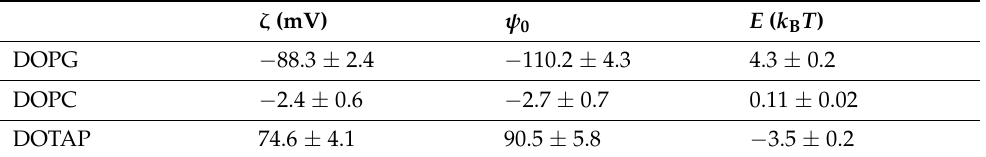
Table 1. Measured zeta potential, ζ , of lipid vesicles of the indicated composition between 20 and 30 ◦ C. The surface potential, ψ 0 , was calculated assuming that the shear plane was located at a distance of 0.4 nm since the salt concentration was equal to 10 mM. We used Equation (13) to calculate the electrostatic surface–proton interaction energy, E . ζ (mV) ψ 0 E ( k B T ) DOPG − 88.3 ± 2.4 − 110.2 ± 4.3 DOPC